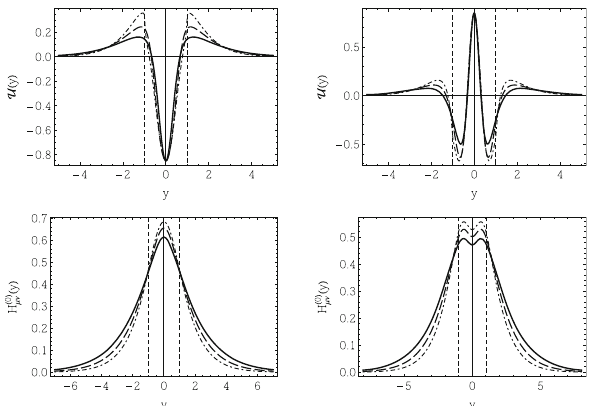
Fig. 22 Potentialofstability(toppanel)andzero-mode(bottompanel) obtained for the model considered in Sect. 3.2 with ψ 0 = ϕ 0 = 10 (left panel) and ψ 0 = − ϕ 0 = − 10 (right panel) and n as in Fig. 6